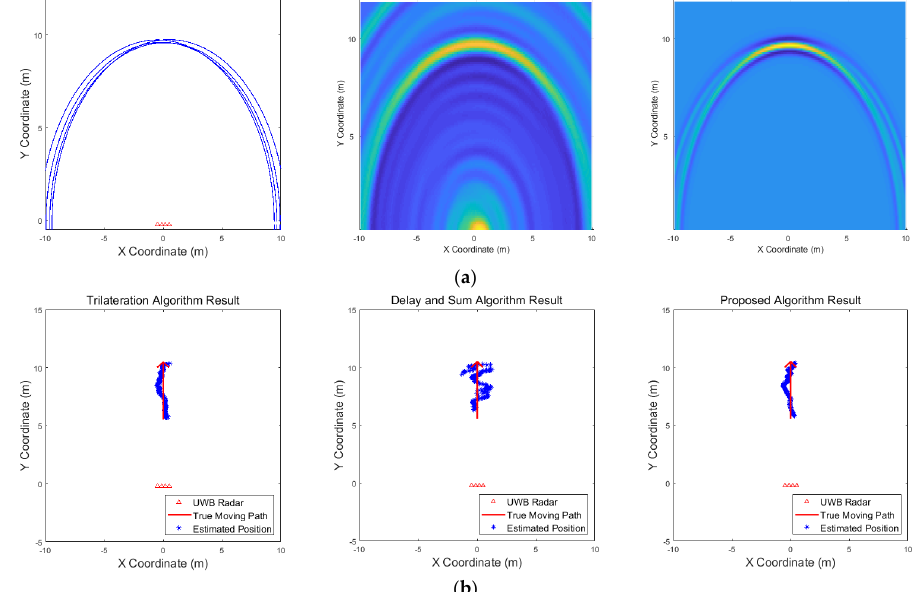
Figure 23. Experimental results when one target moves back and forth behind the wall (Scenario 3): ( a ) instantaneous results of position estimation step according to the positioning algorithm; ( b ) results of the through-wall radar system